Question: Describe this figure in one sentence.
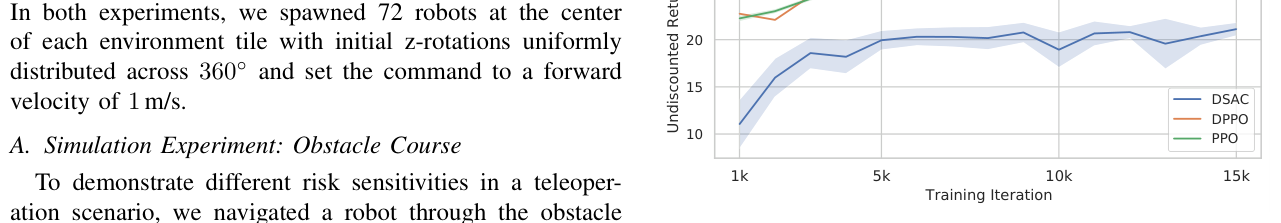
Answer: Average return in the evaluation environment. Shaded regions indicate 95% confidence intervals across seeds and evaluation spawns. Hyperparameters for DPPO were not tuned.